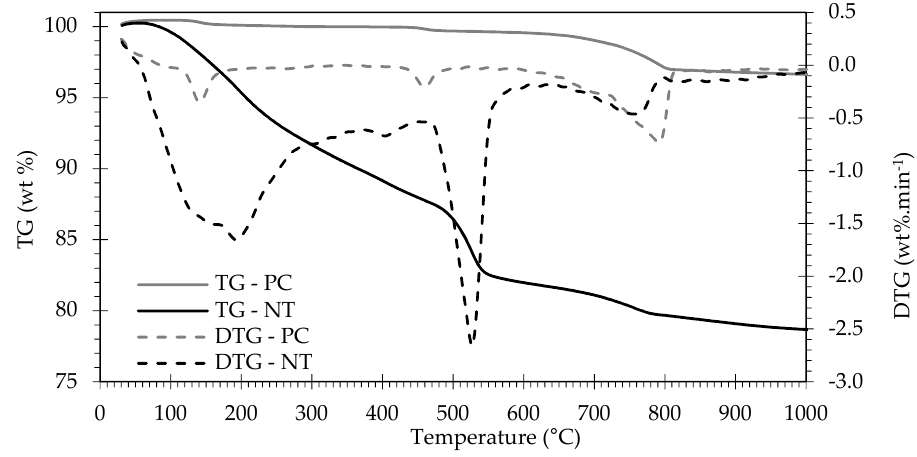
Figure 4. Thermogravimetric analysis: TG curves and first derivative (DTG) of PC and NT.